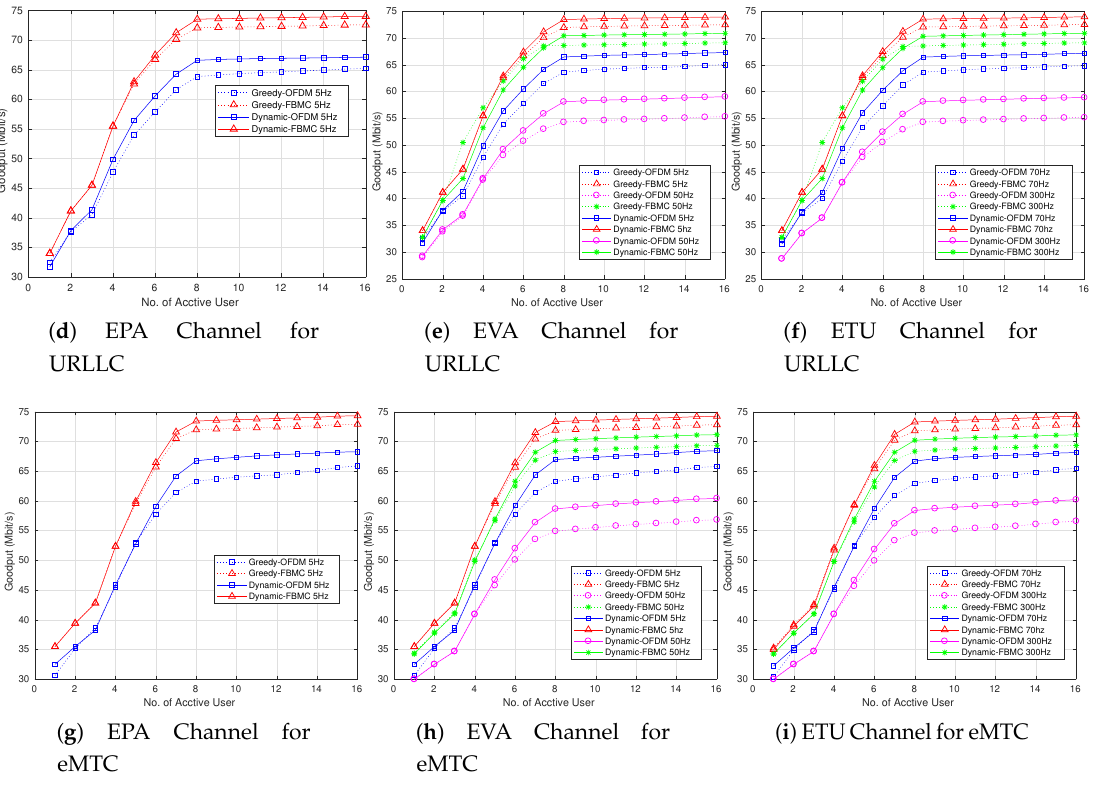
Figure 3. Average goodput results for the greedy and dynamic approaches. EPA, Extended Pedestrian A; EVA, Extended Vehicular A; ETU, Extended Typical Urban; LTE, Long Term Evolution; URLLC, Ultra-Reliable Low Latency Communication; eMTC, enhanced Machine Type Communication.